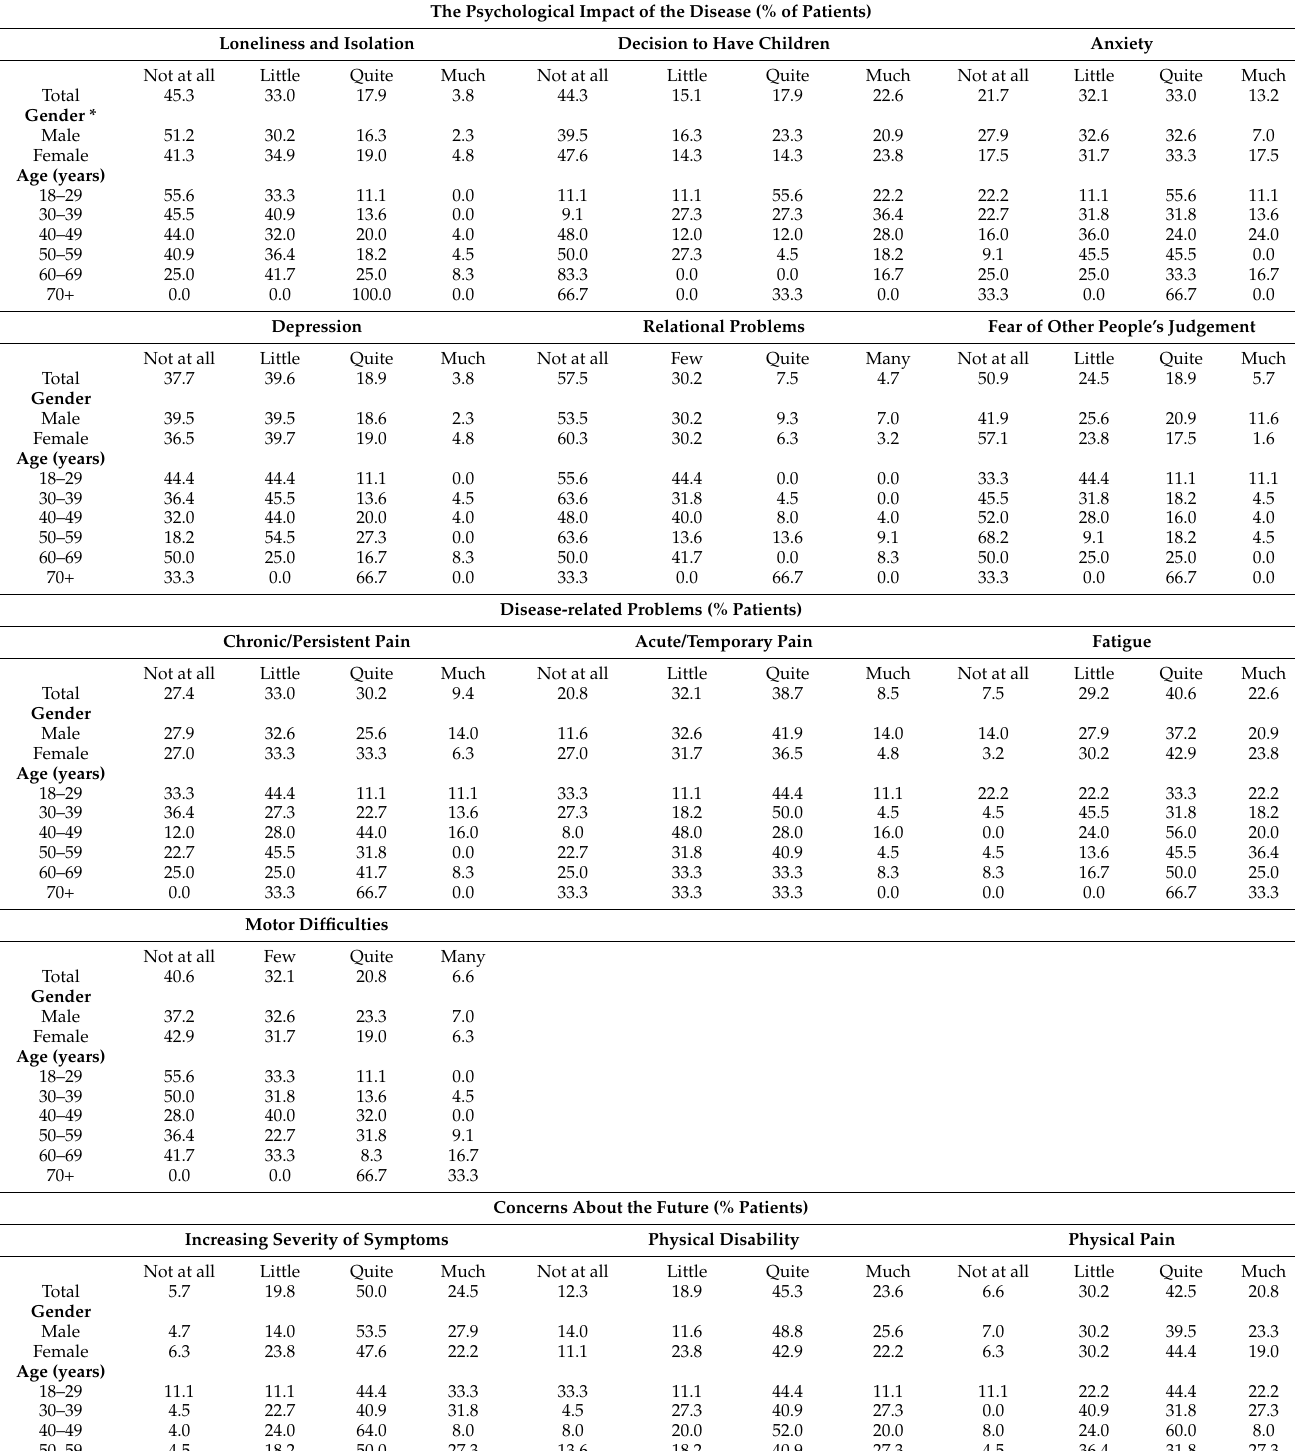
Table 3. Findings resulting from the evaluation of the questionnaire in our cohort of patients with Fabry